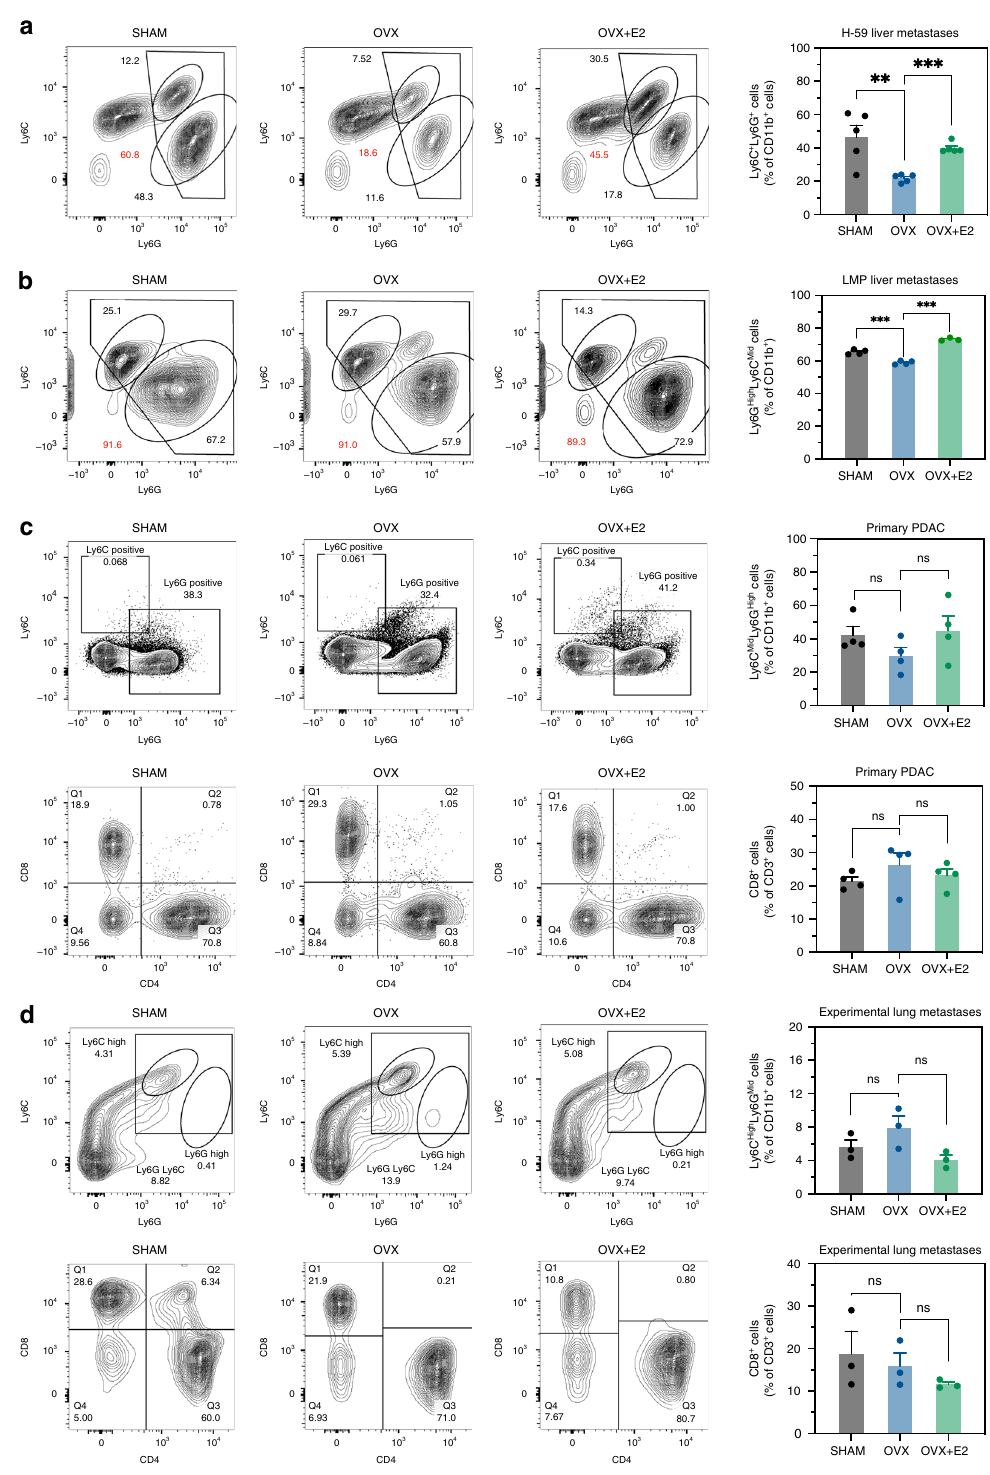
Fig. 6. The effect of estrogen deprivation on the TIME is liver speci fi c. FC was performed on immune cells isolated 7 days post intrasplenic/portal injection of 5 × 10 5 H-59 cells ( a ) or LMP cells ( b ) and immunostained with the indicated antibodies. Orthotopic PDAC tumors were generated by intrapancreatic injections of 1 × 10 6 LMP cells ( c ), and experimental lung metastases were generated by intravenous injections (tail vein) of 5 × 10 5 H-59 cells ( d ). Shown in a , b (left) are representative fl ow cytometric contour plots obtained with each of the indicated immune cells populations (for complete gating strategy, please see Supplementary Fig. 9) and in the bar graphs a , b (right) the mean proportions (%; ±s.e.m.) of MDSC per liver based on four mice per group, analyzed individually. Shown in c (left) are representative fl ow cytometric contour plots obtained with immune cells derived from pancreatic LMP tumors that were fi rst gated for CD45 + cells and in d (left) from experimental lung metastases of H-59 cells that were gated based on viability and size. Shown in the bar graphs c , d (right) are the mean proportions (%; ±s.e.m.) of the indicated immune cells ( n = 3). * − p ≤ 0.05; ** − p ≤ 0.01; *** − p ≤ 0.001; NS, not signi fi cant as determined by the Student's t